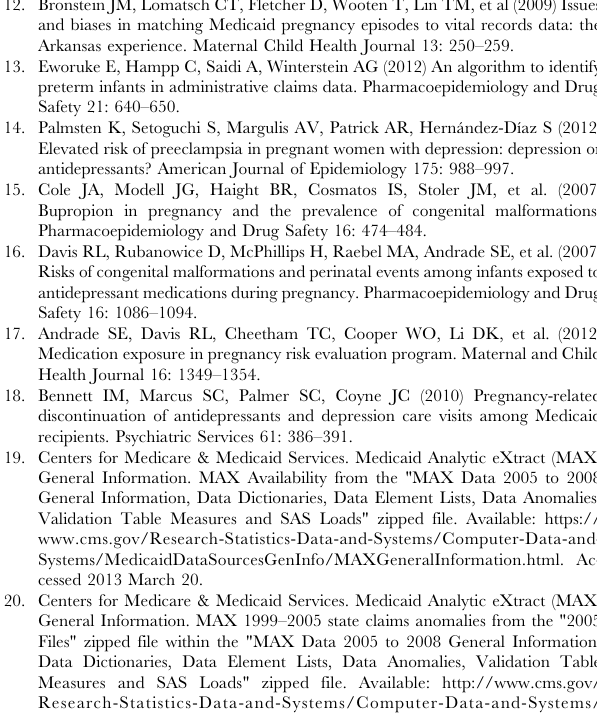
S3: Demographic characteristics on the delivery date